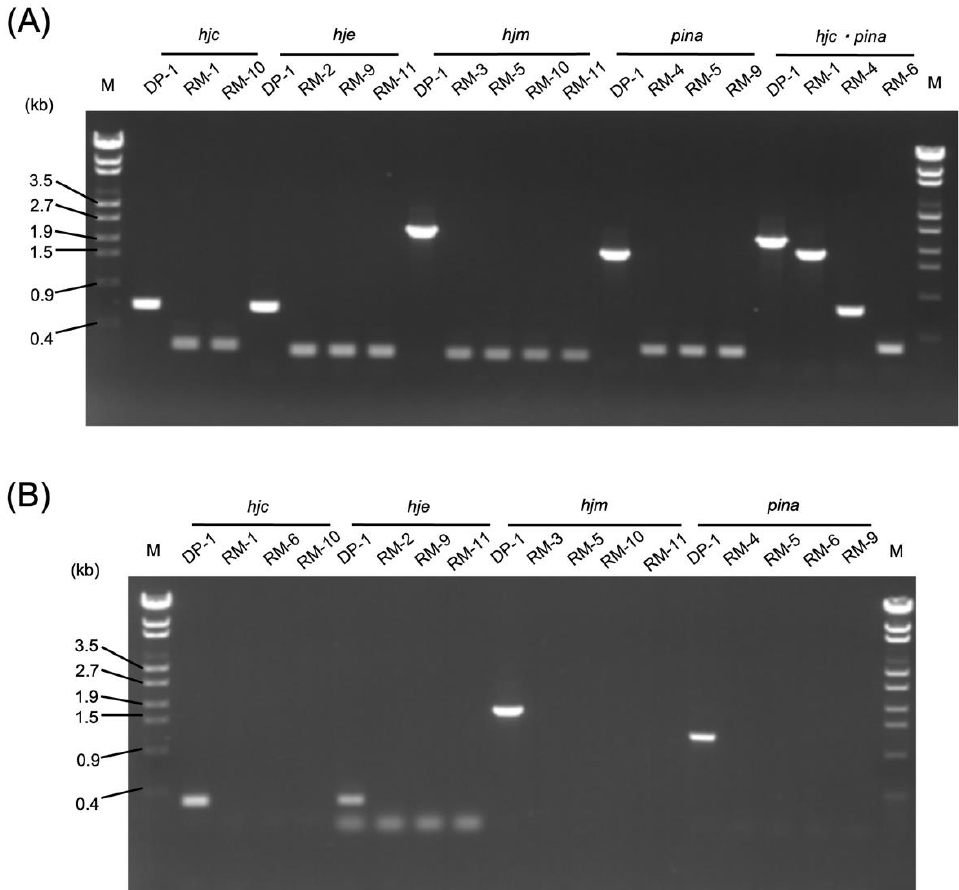
Figure 2. ( A ) PCR analysis of the hjc , hje , hjm , and pina of the locus of the gene-deleted strains using outer primers (Hjc-out-F/R, Hje-out-F/R, Hjm-out-F/R, PINA-out-F/R, and Hjc-out-F/PINA-out-F). The expected sizes of the PCR bands were as follows: 0.7 kb (DP-1), 0.2 kb (RM-1), and 0.2 kb (RM-10) in the hjc locus; 0.6 kb (DP-1), 0.2 kb (RM-2), 0.2 kb (RM-9), and 0.2 kb (RM-11) in the hje locus; 2.3 kb (DP-1), 0.2 kb (RM-3). 0.2 kb (RM-5), 0.2 kb (RM-10), and 0.2 kb (RM-11) in the hjm locus; and 1.7 kb (DP-1), 0.3 kb (RM-4), 0.3 kb (RM-5), and 0.3 kb (RM-9) in the pina locus; 2.4 kb (DP-1), 1.9 kb (RM-1), 1.0 kb (RM-4), and 0.2 kb (RM-6) in the hjc and pina locus. A λ -EcoT14 ladder was loaded in lane M. ( B ) PCR analysis of the hjc , hje , hjm , and pina of the locus of the gene-deleted strains using inner primers (Hjc-in-F/R, Hje-in-F/R, Hjm-in-F/R, and PINA-in-F/R). The expected sizes of the PCR bands were as follows: 0.3 kb (DP-1), no band (RM-1), no band (RM-6), and no band (RM-10) in the hjc locus; 0.3 kb (DP-1), no band (RM-2), no band (RM-9), and no band (RM-11) in the hje locus; 1.7 kb (DP-1), no band (RM-3), no band (RM-5), no band (RM-10), and no band (RM-11) in the hjm locus; and 1.2 kb (DP-1), no band (RM-4), no band (RM-5), no band (RM-6), and no band (RM-9) in the pina locus. A λ -EcoT14 ladder was loaded in lane M. The gene-deleted strains were designated the S. acidocaldarius strains RM-1 ( ∆ pyrE ∆ suaI ∆ phr ∆ hjc ), RM-2 ( ∆ pyrE ∆ suaI ∆ phr ∆ hje ), RM-3 ( ∆ pyrE ∆ suaI ∆ phr ∆ hjm ), and